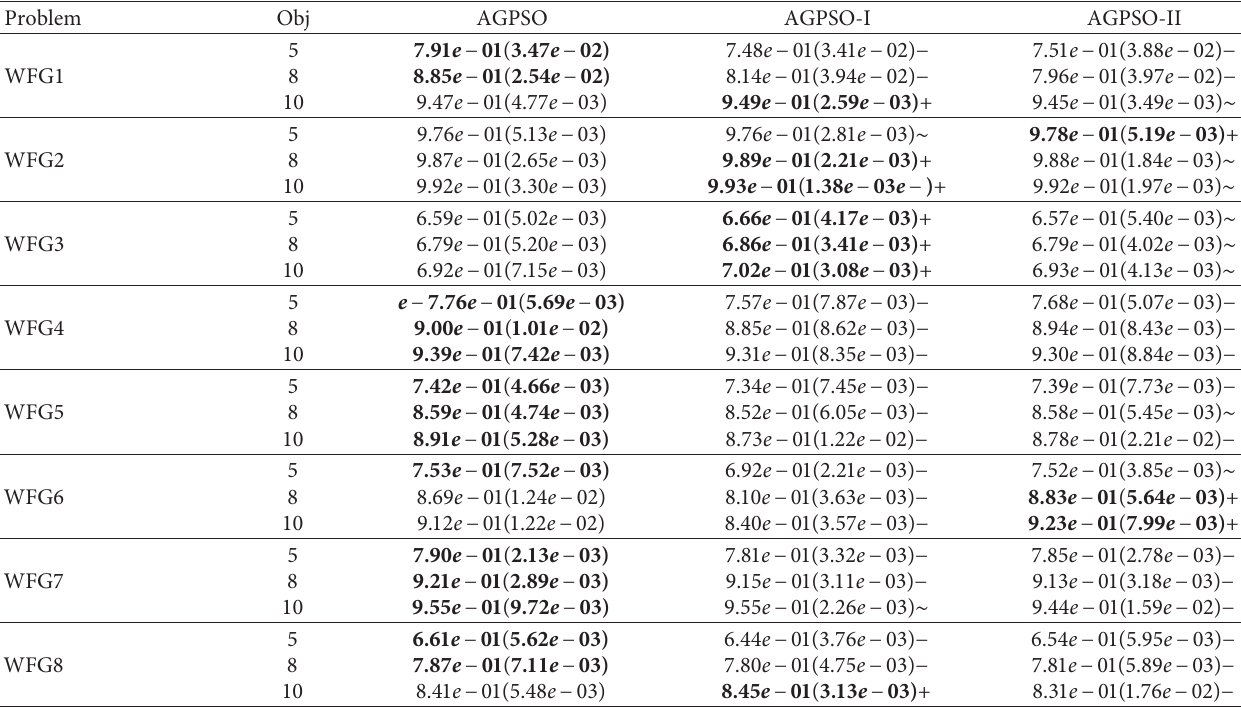
Figure 4: The HV trend charts (averaged over 30 runs) of AGPSO, SPEA2+SDE, and NMPSO on WFG3, WFG4, and MaF2 with 10 objectives. Table 6: Comparison of results of AGPSO with different velocity using